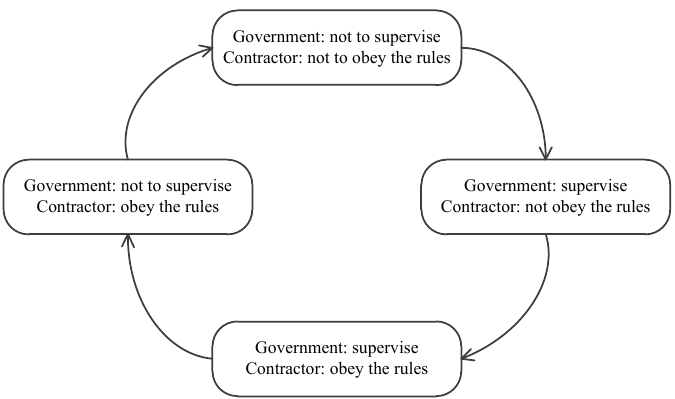
Figure 8. Diagram on dynamic evolution of equilibrium points in